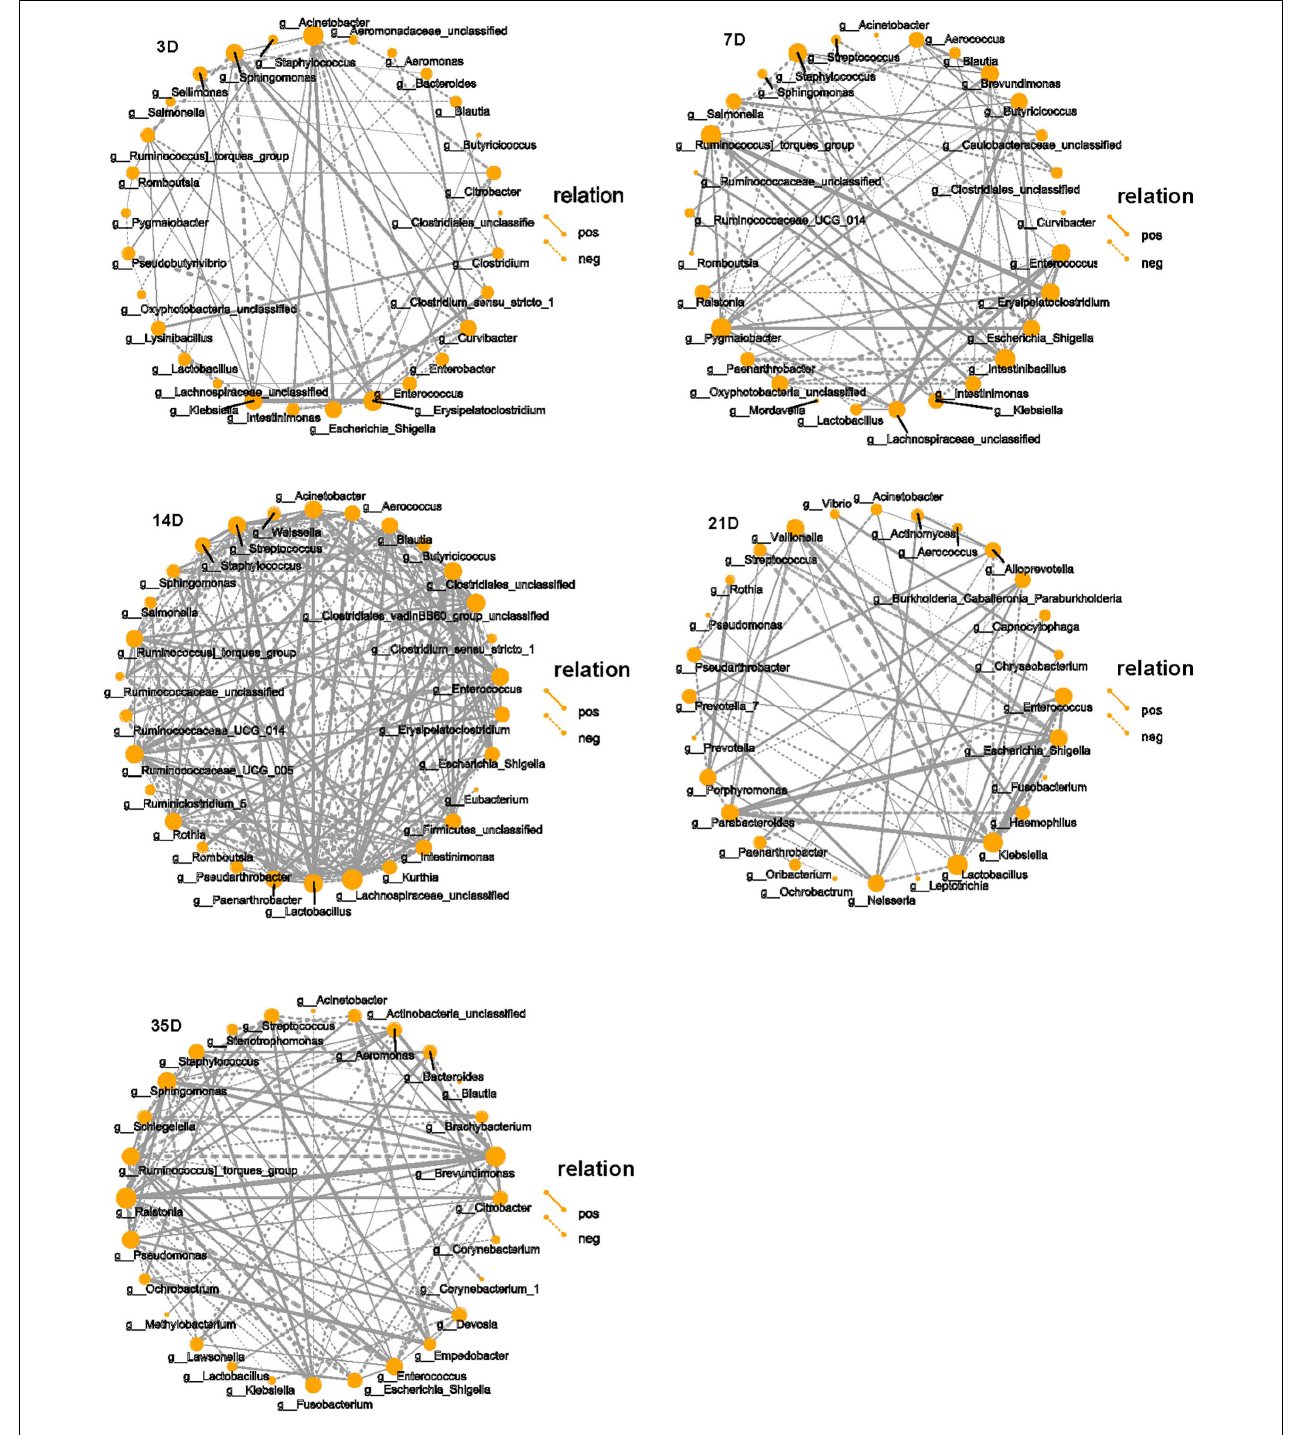
FIGURE 4 | Correlation network of microbiota in each group. SparCC was used to calculate the correlation among the top 30 species in each group and drawing the networks. The solid line indicates the positive correlation, the dashed line indicates the negative correlation, the thickness of the line reflects the strength of the correlation, and the size of the point indicates the number of points that is related to that point. Only showed the relational pair when the correlation coefficient | rho| > 0.4.